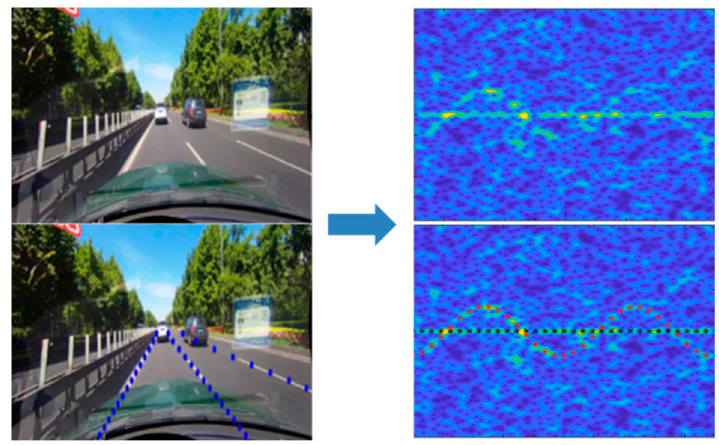
Figure 1. Semantic line detection and radar signal extraction.